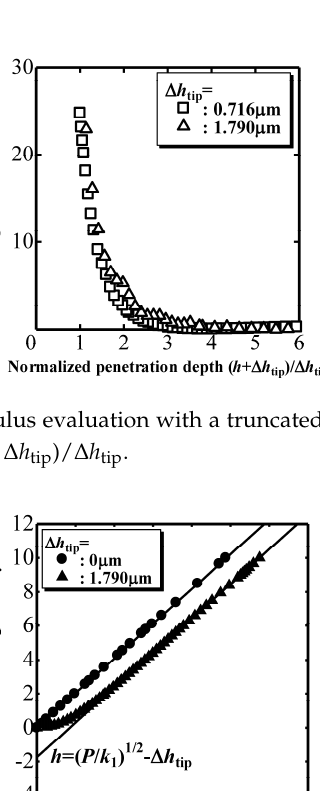
Figure A5. Penetration depth h vs. square root of indentation load P *** obtained with truncated indenters.